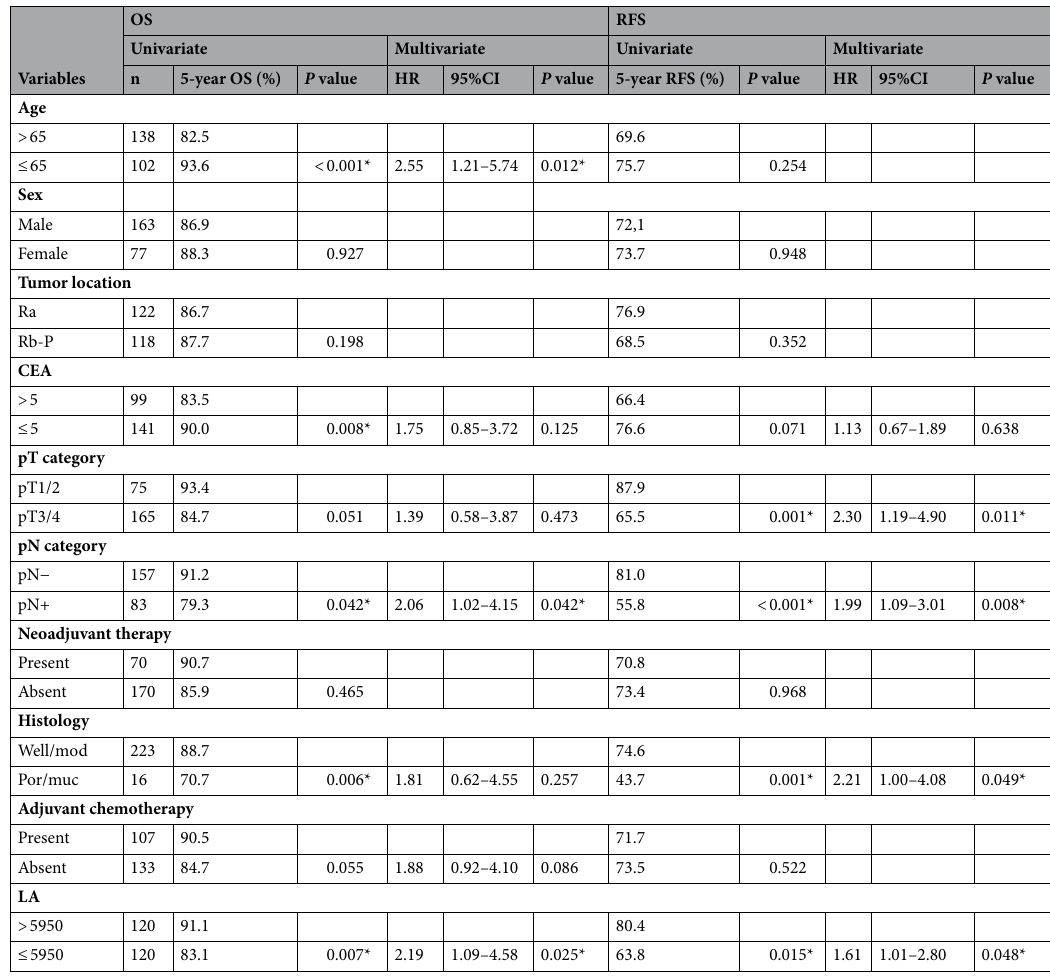
Table 3. Univariate and multivariate analysis using clinicopathological characteristics and LA for overall survival (OS) and recurrence-free survival (RFS) in the discovery cohort. CEA carcinoembryonic antigen, well/mod well-differentiated/moderately-differentiated, por/muc poorly-differentiated/mucinous, LA lymphocyte × albumin, HR hazard ratio, CI confidence interval. * P <